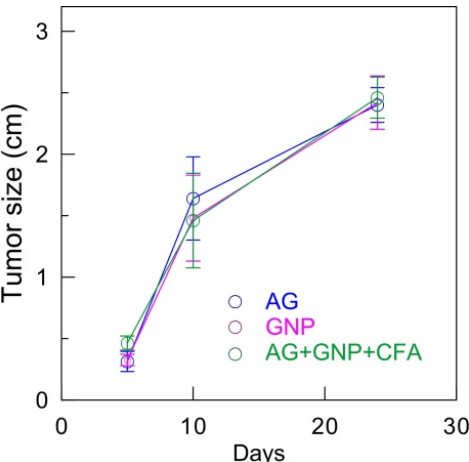
Figure 7. Tumor growth dynamics after immunization and subsequent tumor cell transplantation.